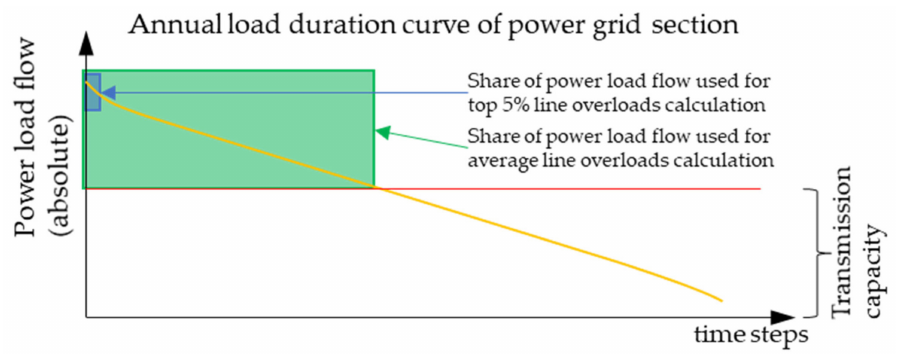
Figure 14. General determination of line overloads (an average and the top five per cent).